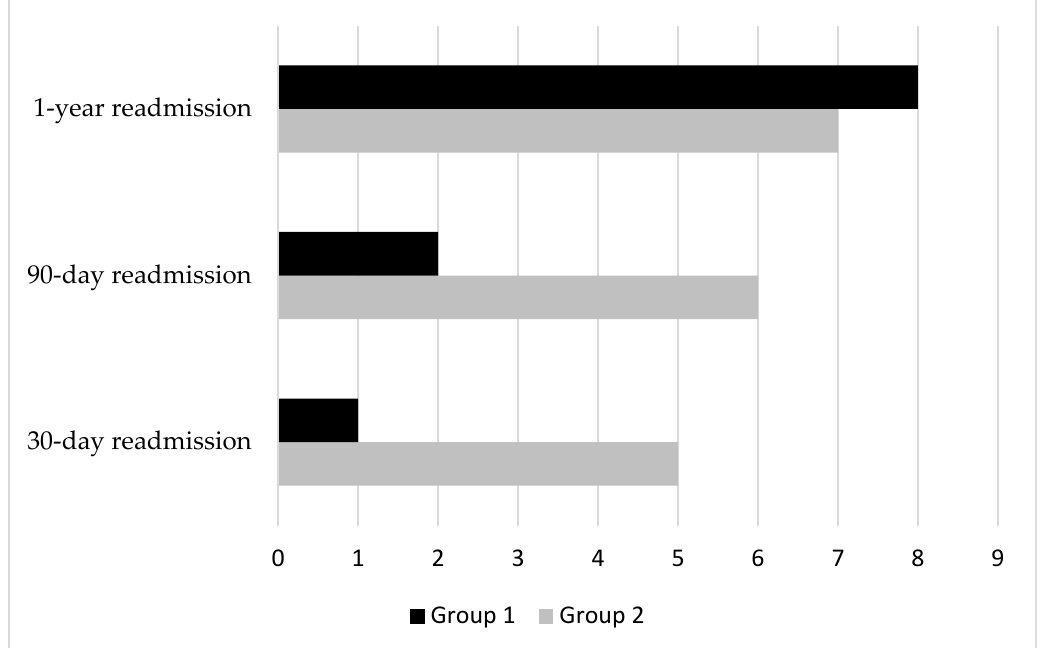
Figure 4. 30-day, 90-day, and 1-year hospital readmission rates in the two groups. Factors significantly associated with early mobilization after surgery are